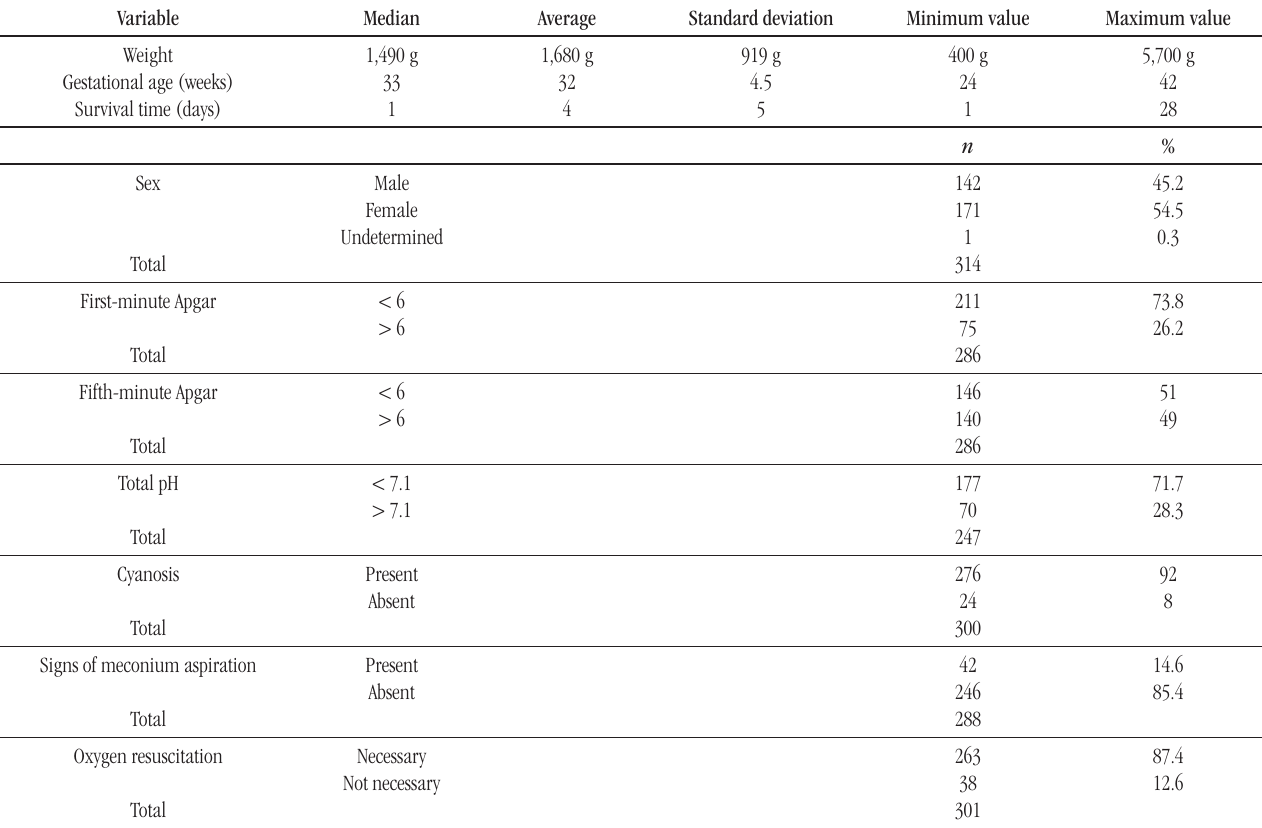
taBLE 2 − Clinical, epidemiological and laboratory profile of the studied population ( n =